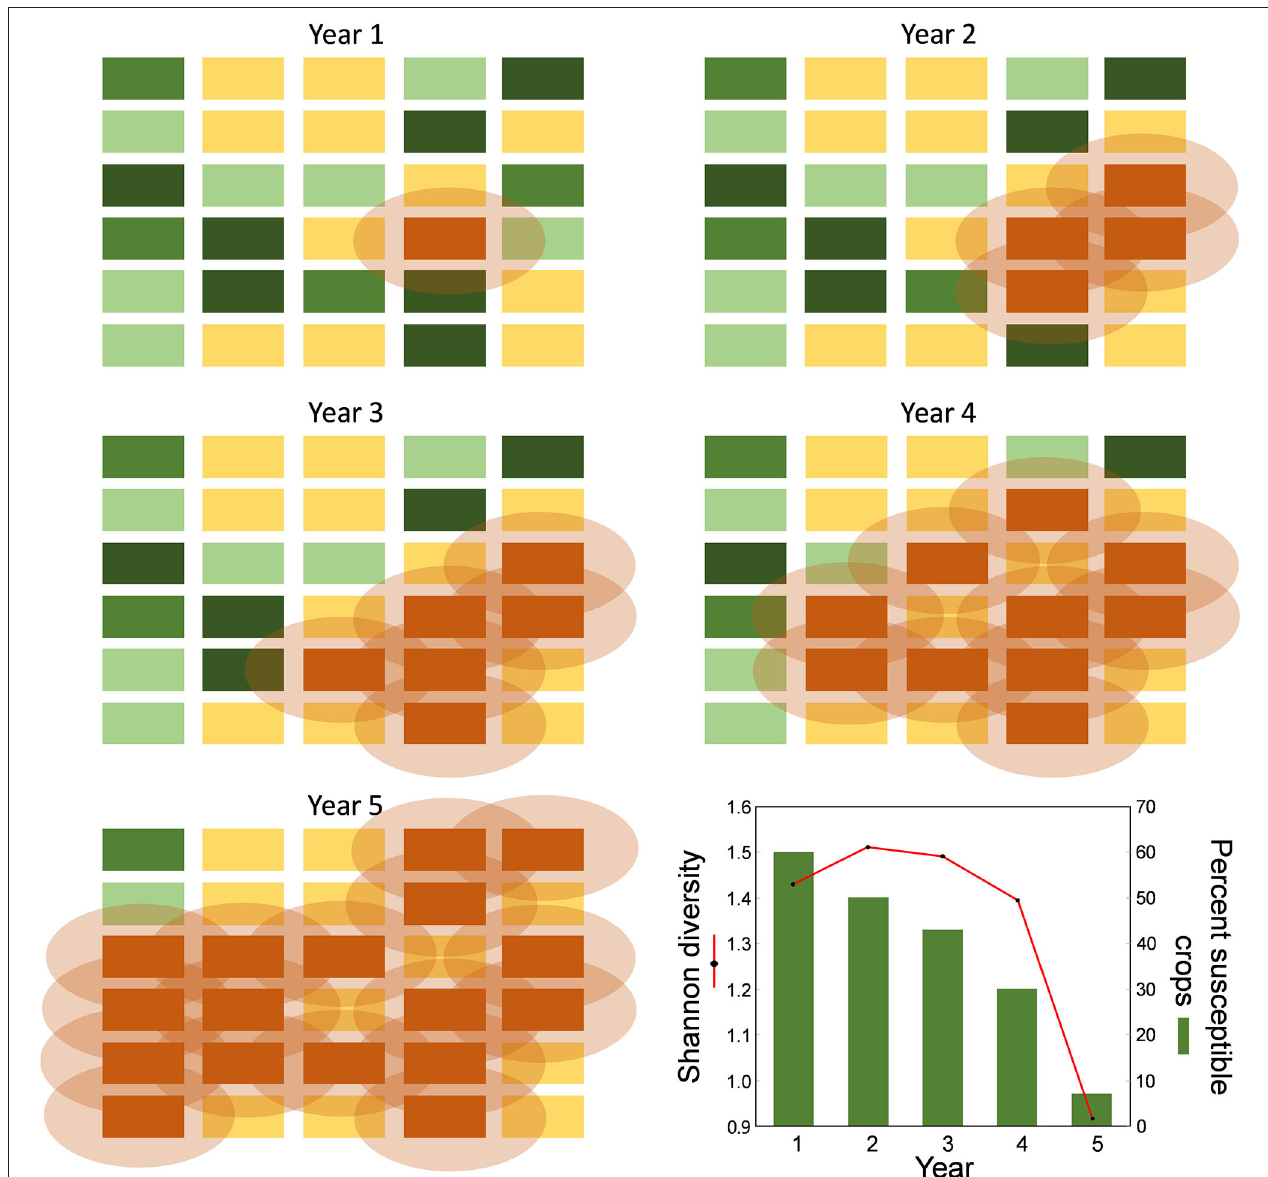
FIGURE 2 | Change in crop diversity across a hypothetical agricultural landscape over 5 years following the introduction of a reinforcing factor that drives defensive simplification of neighboring cropping systems. Each rectangle represents a field or farm. In this example, the orange field/farm in year 1 adopts a new crop or cropping practice associated with off-target effects that manifest on neighboring fields (i.e., dicamba herbicide vapor drift that travels beyond the confines of the field to which it is applied). Here we assume that off-target movement of the herbicide extends some distance from the field on which it is applied, represented by the “drift cloud” (shaded oval), and causes damage to susceptible crops (shades of green) but not resistant (orange) or tolerant (yellow) crops in farms/fields that are located immediately adjacent to the offending farm. As a defensive measure, farms that experience an unacceptable level of damage in a given year, represented by at least some portion of the field covered by the drift cloud, switch to the new cropping practice the following year. Farms/fields adjacent to the new adopters of the practice are subsequently impacted and then adopt defensive planting of resistant cultivars in the following year. The result of this dynamic over time is an overall reduction in crop diversity at the landscape level (bottom right